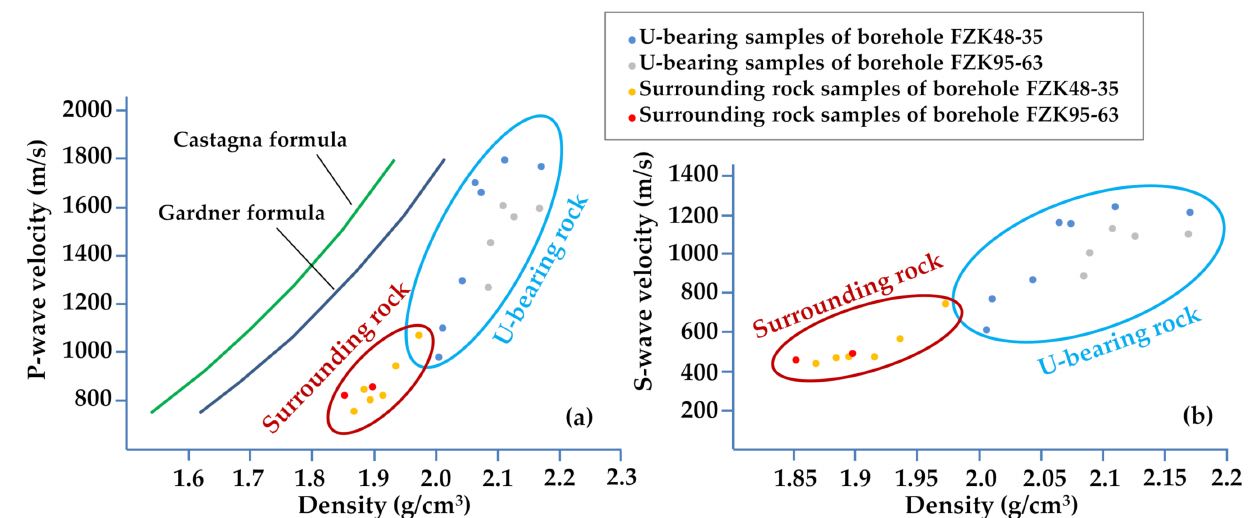
Figure 15. Experimental results of petrophysical parameters for uranium-bearing rock and the surrounding rock in the Hadatu deposits. ( a ) p -wave and density; ( b ) s -wave and